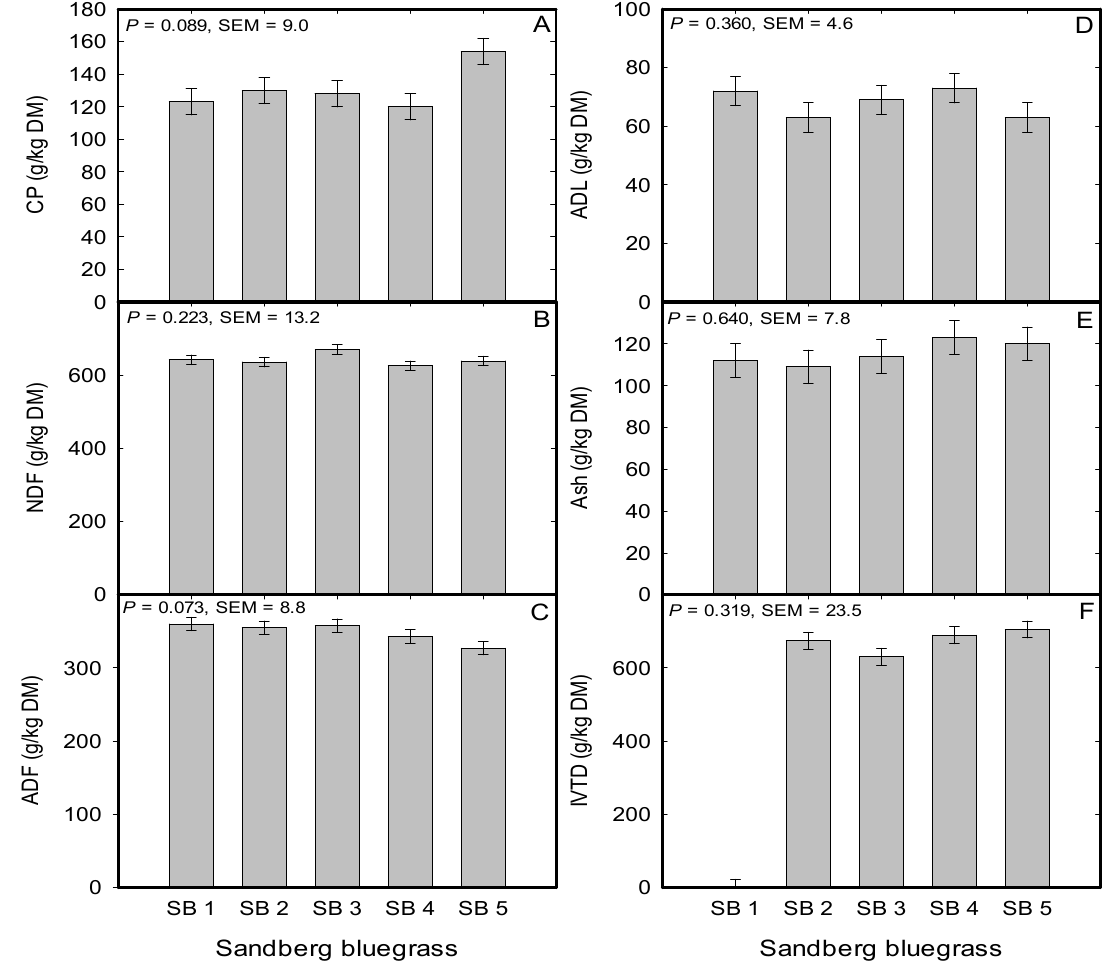
Figure 3. Mean ( A ) crude protein (CP), ( B ) neutral detergent fiber (NDF), ( C ) acid detergent fiber (ADF), ( D ) acid detergent lignin (ADL), ( E ) ash, and ( F ) in vitro true digestibility of Sandberg Bluegrass (expressed in gram per kilogram of dry matter (DM)) evaluated under greenhouse conditions during 2015 to 2016 at the University of Nevada, Reno, USA. SB 1; Button Point (LP), SB 2; Panther Valley (LP), SB 3; Winnemucca Mountain (LP), SB 4; Hanford (CV), SB 5; Mountain Home (CV). LP; local population, and CV;